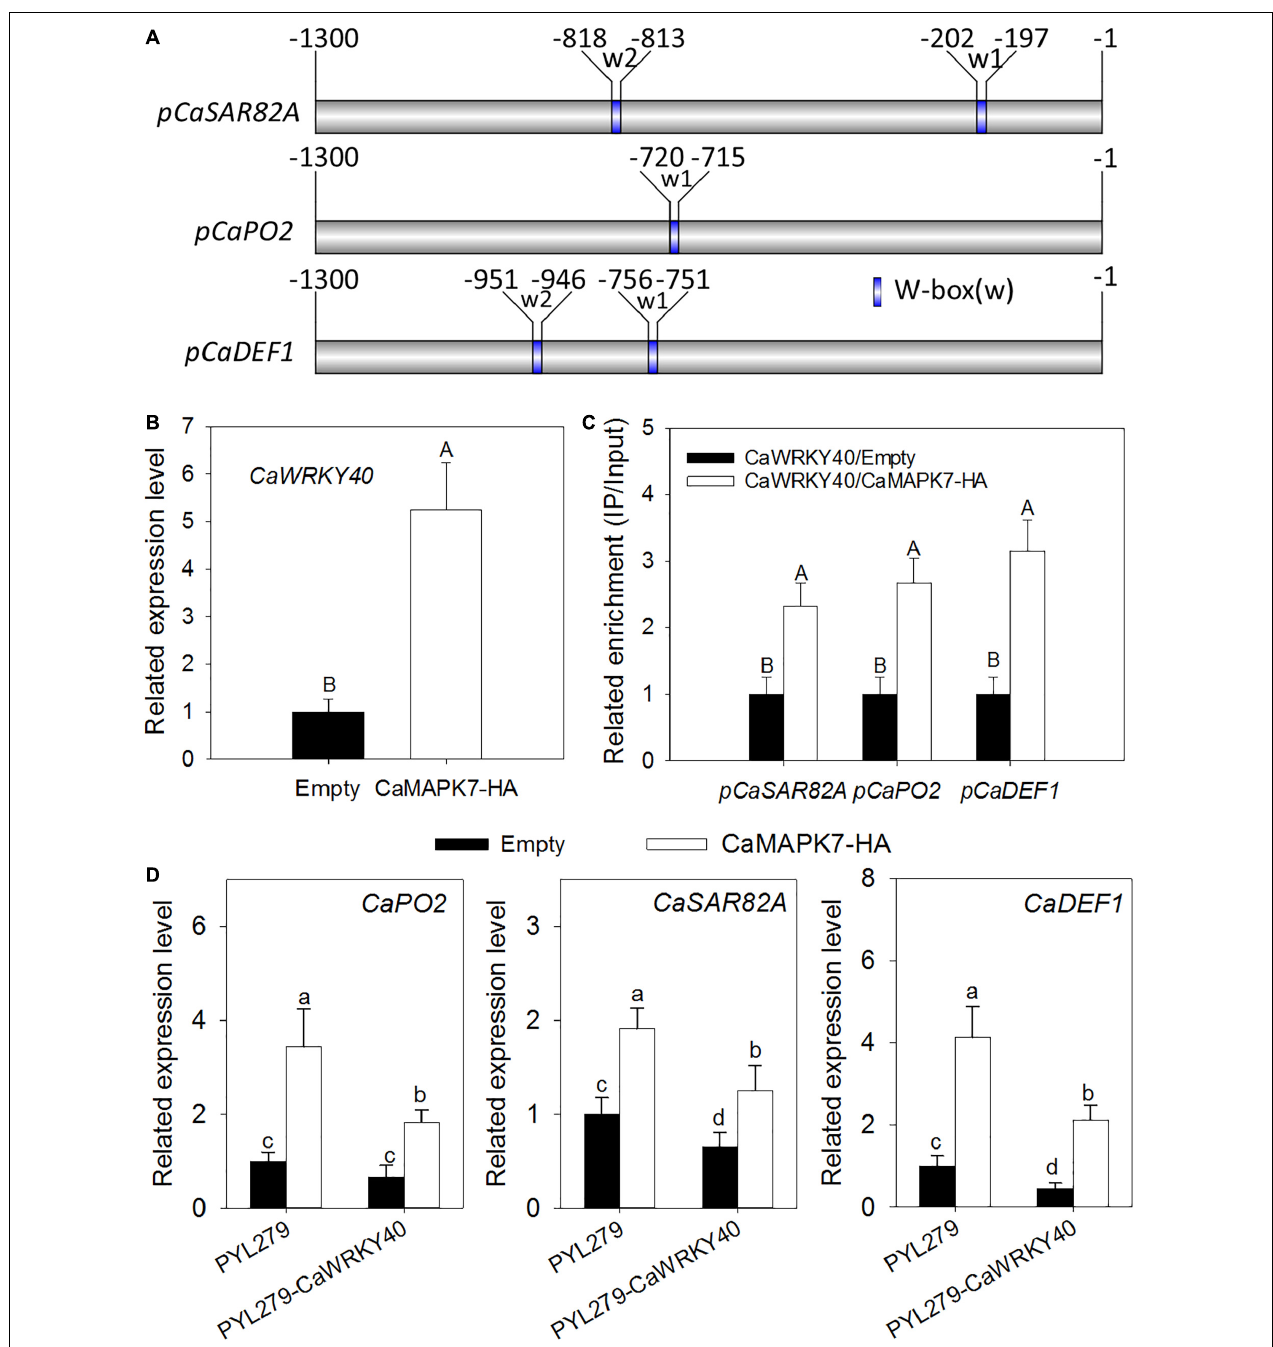
FIGURE 8 | The transcriptional expression of CaWRKY40 triggered by CaMAPK7 overexpression and the bindings of CaWRKY40 to the promoters of its target genes were enhanced by CaMAPK7 expression. (A) Schematic representation of a typical W-box in the promoters of CaWRKY40 downstream defense marker genes. (B) CaWRKY40 transcript level triggered by CaMAPK7 overexpression in pepper leaves. The CaWRKY40 transcript level in pepper leaves transient expressed empty vector was set to “1.” (C) The binding of CaWRKY40 to the promoters of its target genes was enhanced by CaMAPK7 transient expression in pepper plants. Relative enrichment levels of samples of the CaWRKY40 transient overexpression were set to “1” after normalization by input. (D) Real-time PCR analysis of the defense-associated marker genes in CaWRKY40 -silenced pepper leaves transiently overexpressing CaMAPK7 . The expression of defense-related marker genes in unsilenced pepper leaves transiently expressing vector was set to “1.” (B–D) Data are the means ± SD from at least three independent experiments. Different letters above the bar show a significant difference between the means of the three biological replicates based on Fisher’s protected LSD test: uppercase letters, p < 0.01; lowercase letters, p < 0.05. SD, standard